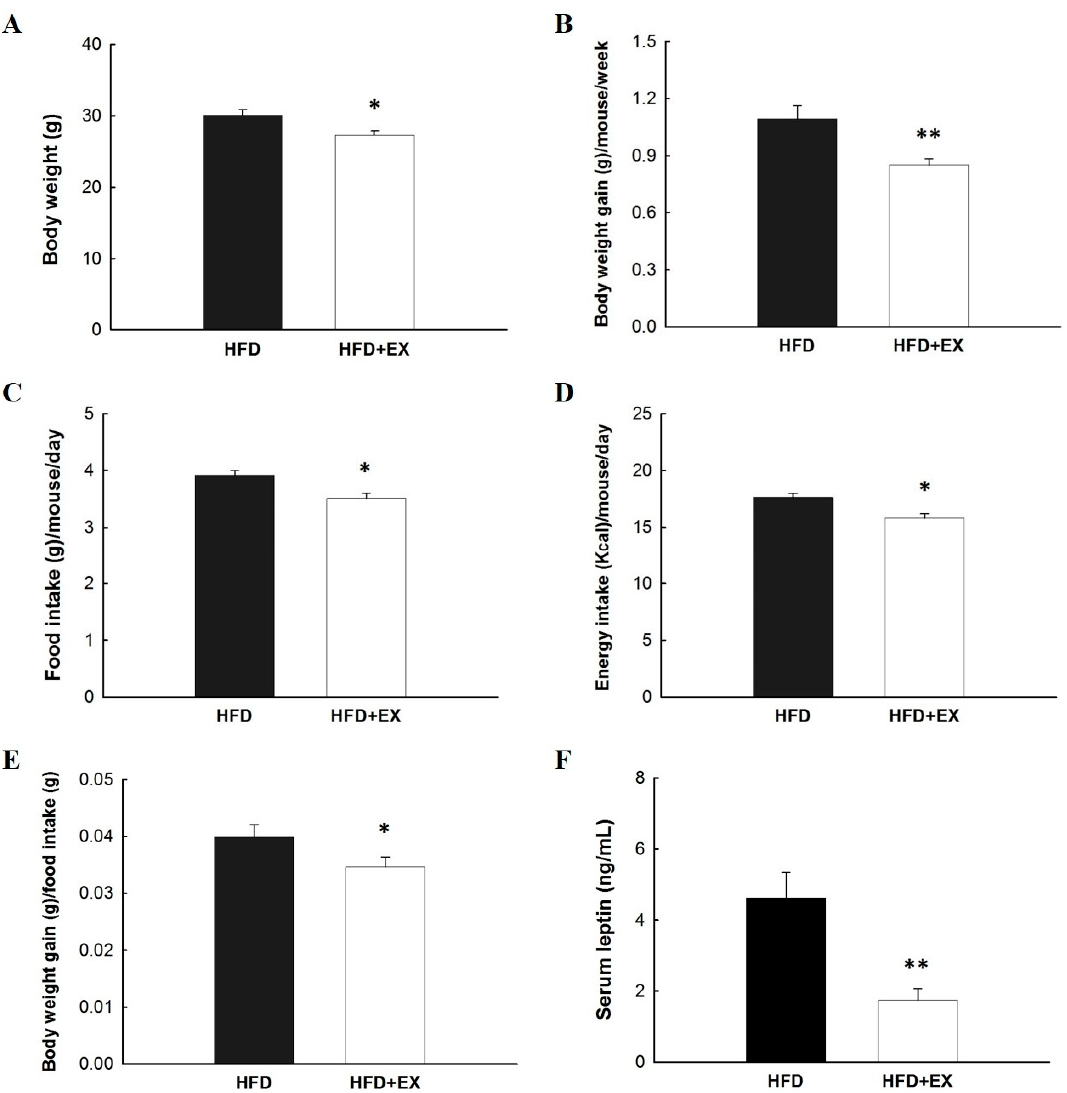
Figure 1. Effects of diet on ( A ) body weight, ( B ) body weight gain, ( C ) food intake per mouse day measured, ( D ) energy intake per mouse day measured, ( E ) daily food efficiency, and ( F ) serum leptin levels in mice after 12 weeks ad libitum consumption of high-fat diet (HFD). All values are given as mean ± SEM, n = 8 for all groups. Statistical significance at * P < 0.05 and highly statistically significant at ** P < 0.01.